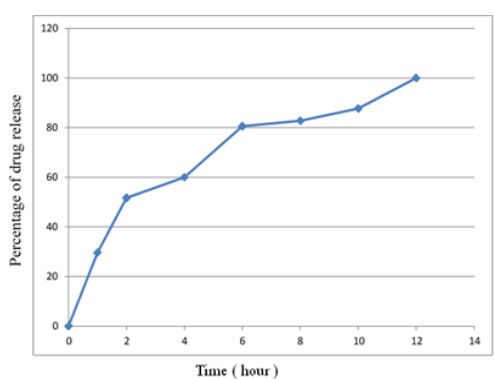
Figure 15. The percentage of drug release from formula sixteen per time at pH 6.8 and